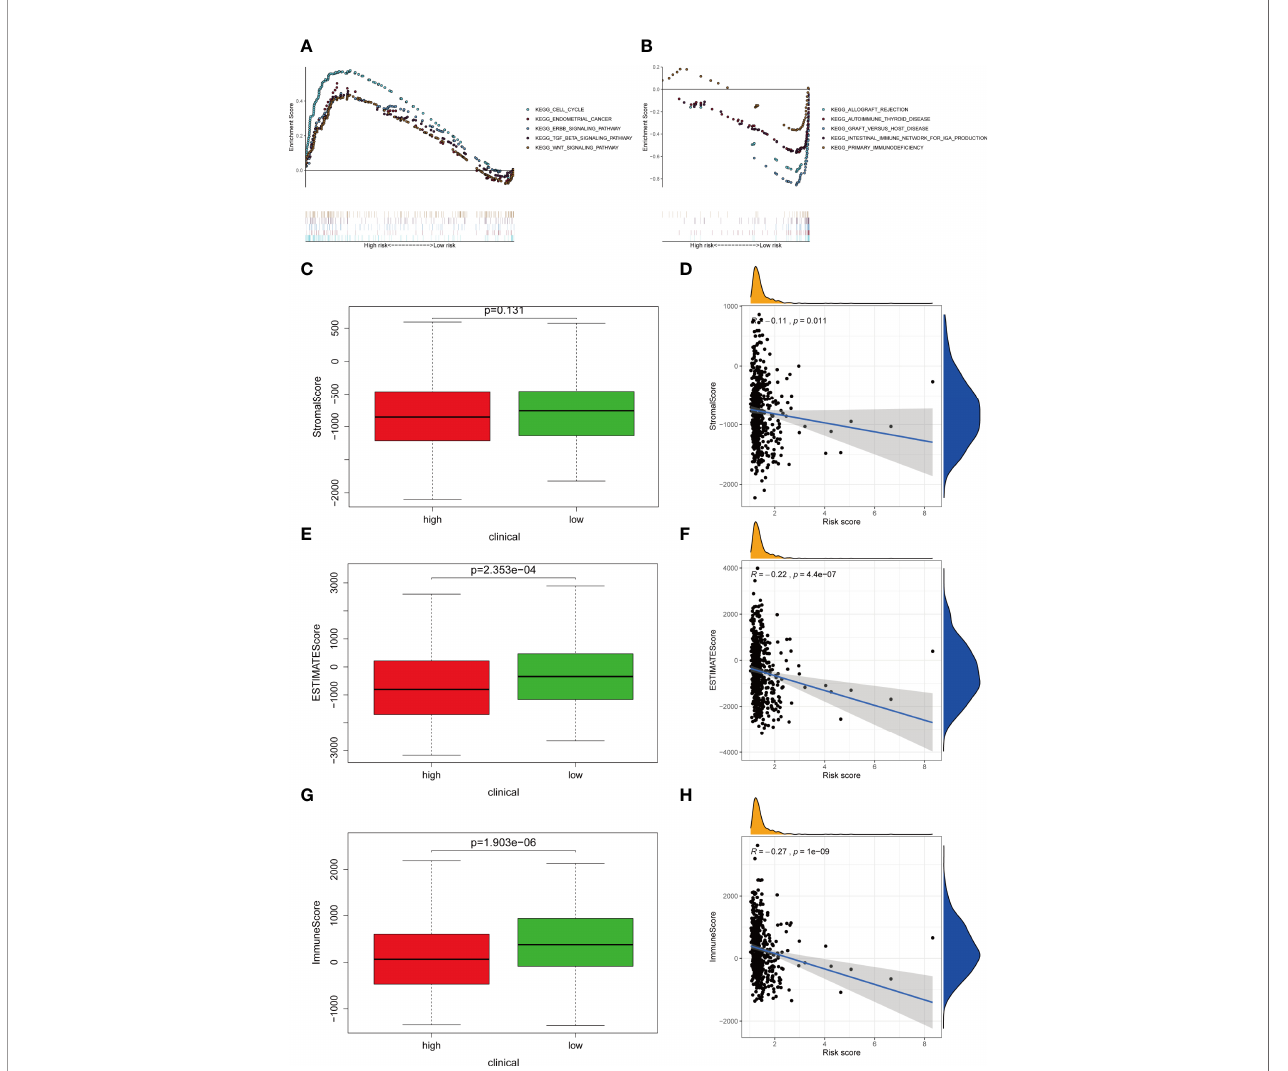
FIGURE 7 | Differentially activated pathways and immune in fi ltration between the groups. (A, B) Multiple GSEA analysis was conducted to predict the potential functions and pathways involved in (A) high-risk and (B) low-risk groups. (C, D) Stromal score does not differ signi fi cantly between the groups. However, correlation analysis implies signi fi cant relationship between stromal score and IRLPS. (E, F) ESTIMATE score differs signi fi cantly between the groups, and correlation analysis implies a signi fi cant relationship between ESTIMATE score and IRLPS. (G, H) Immunescore differs signi fi cantly between the groups, and correlation analysis implies a signi fi cant relationship between Immunescore and IRLPS risk